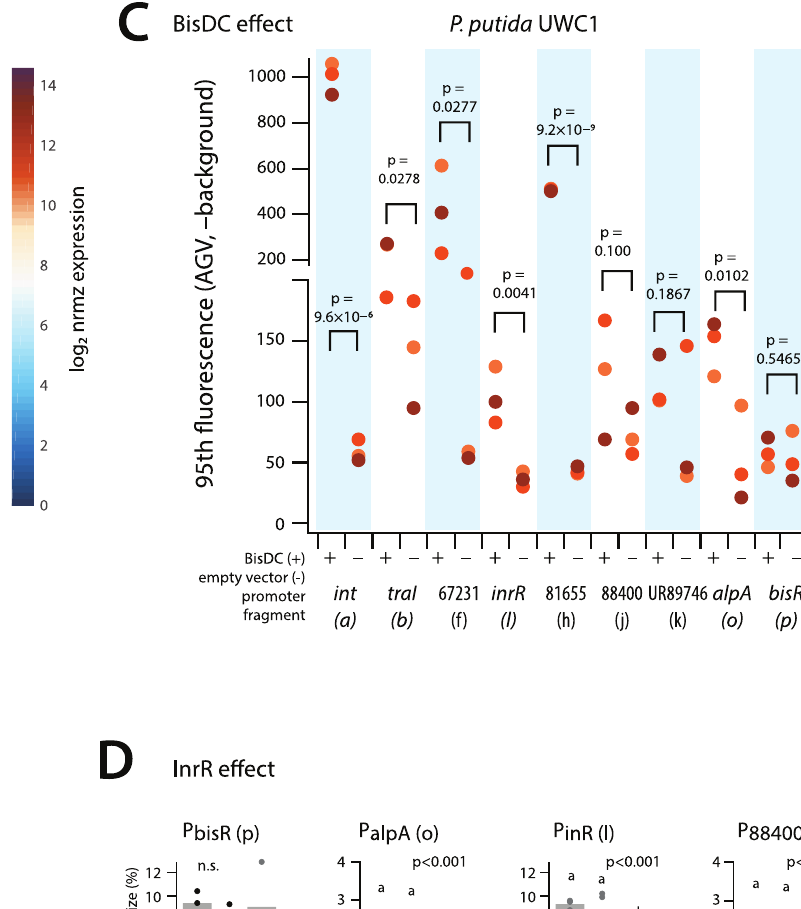
PLOS Genetics | https://doi.org/10.1371/journal.pgen.1010286 June 28,